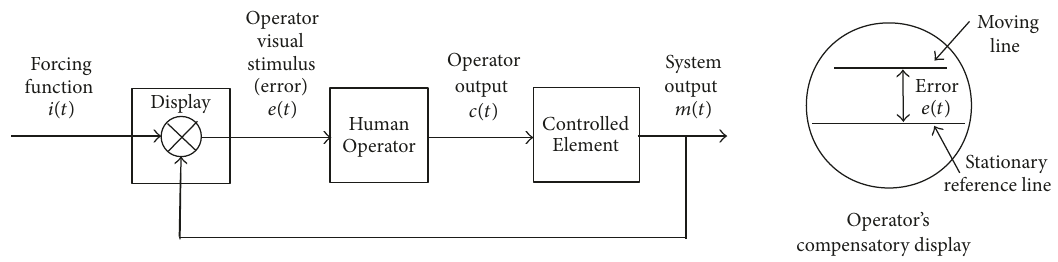
Figure 5: Single loop compensatory scheme. From [15].